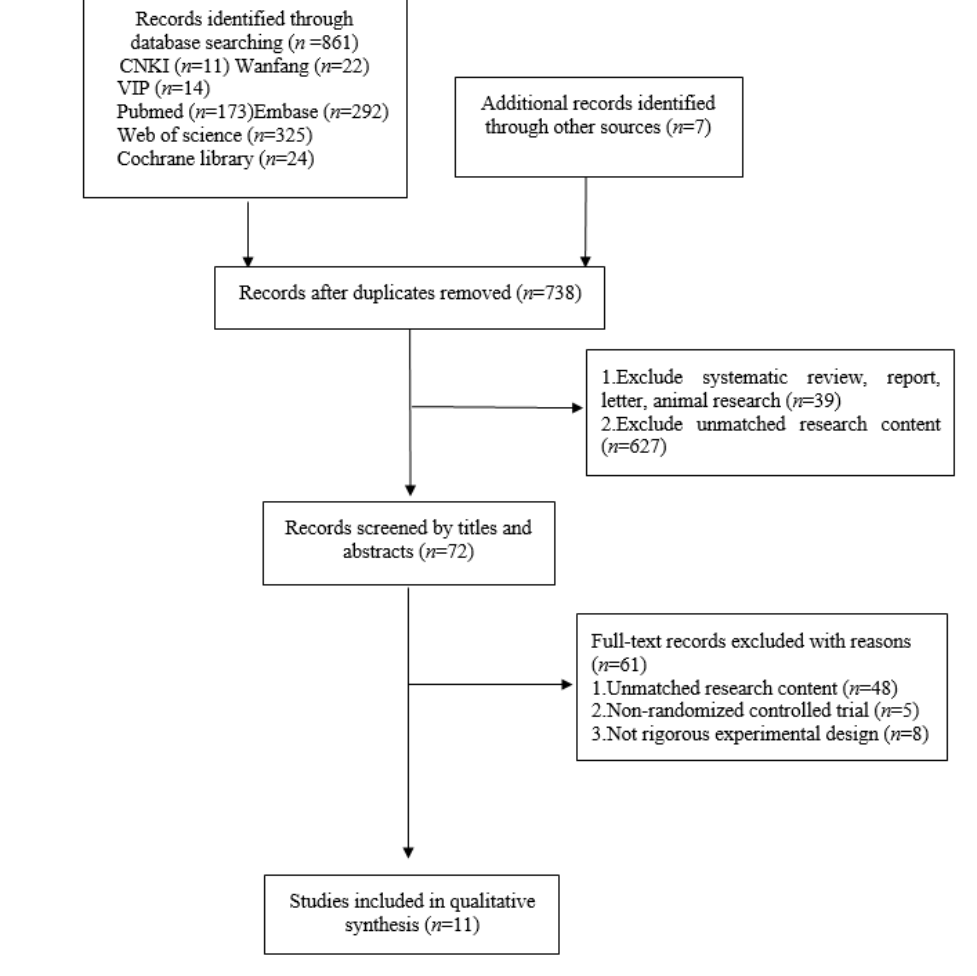
Figure 1. Flow diagram of literature selection.